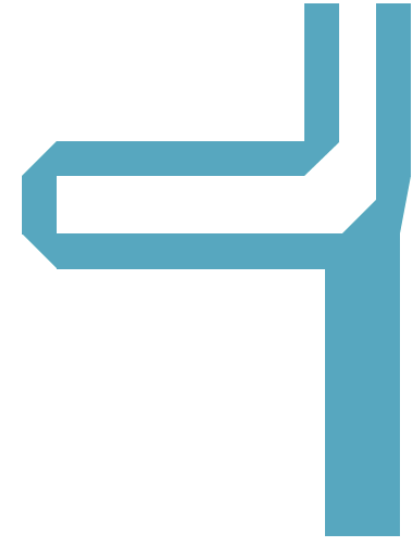
Figure 8: The schematic diagram of balun.